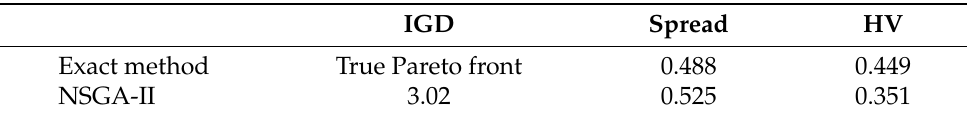
Table 7. Comparing Pareto fronts for PolySCIP and